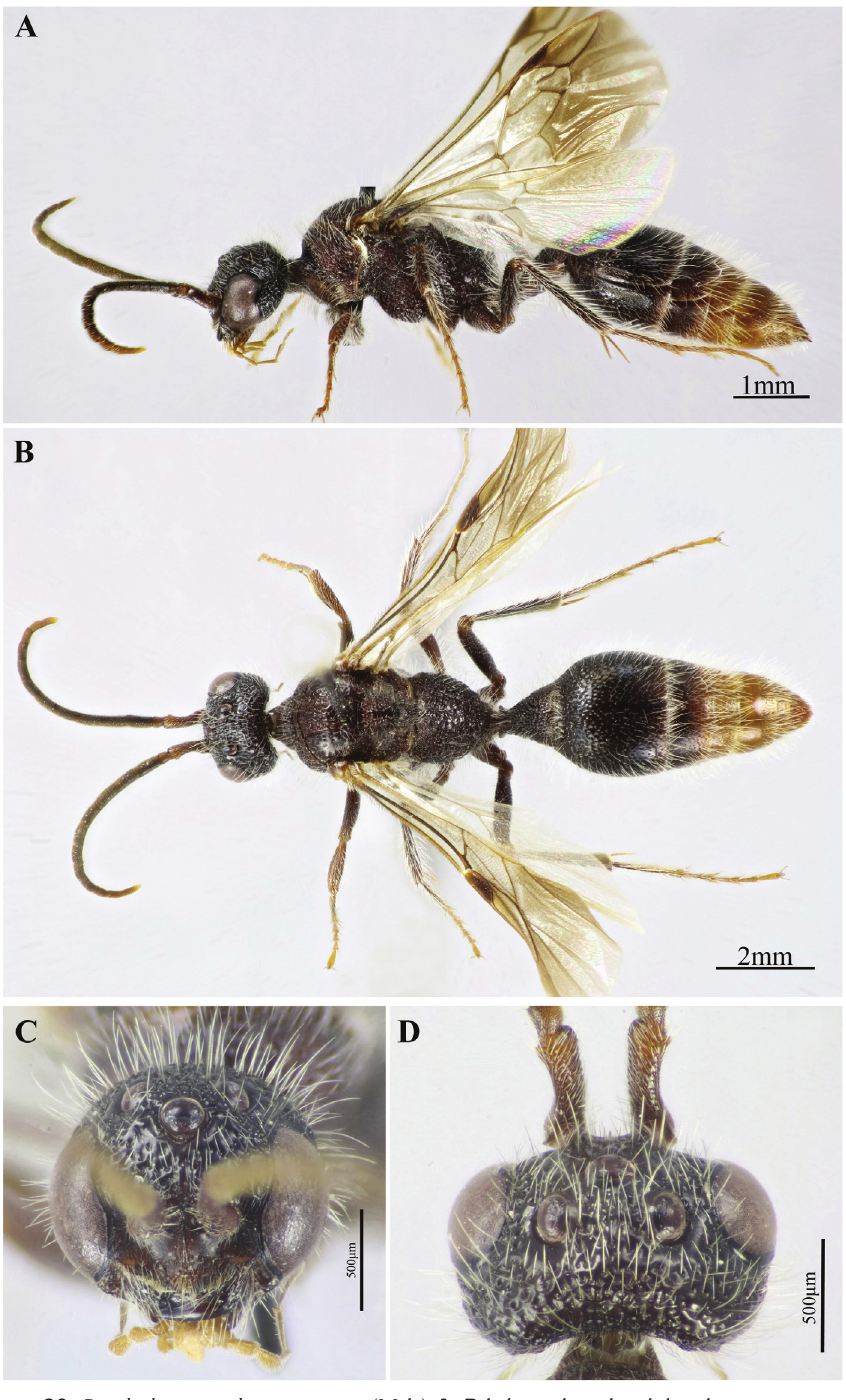
Figure 29. Pseudophotopsis subaurea sp. nov. (Male) A, B habitus, lateral and dorsal views, respectively C head, frontal view D head and antennal scape, dorsal